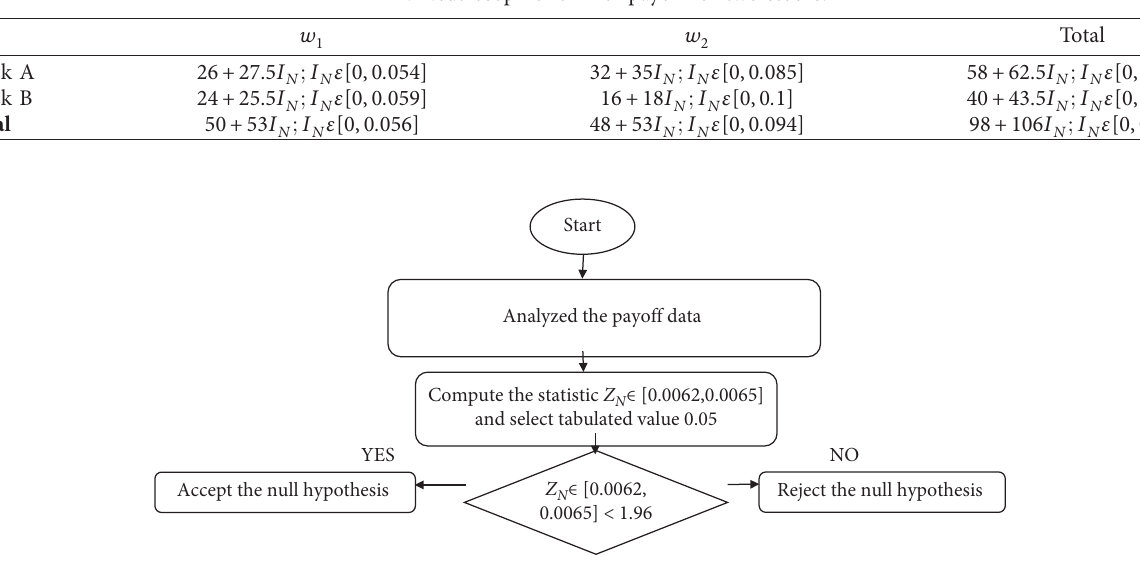
Figure 1: The procedure of the proposed test for real